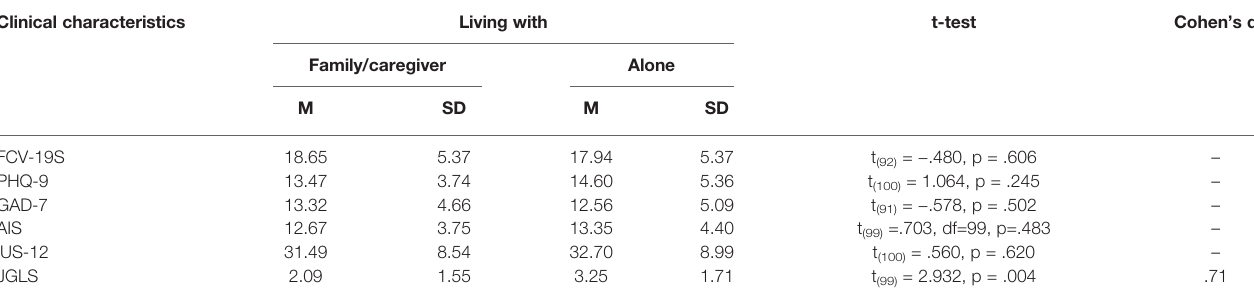
TABLE 2 | Clinical characteristics in relation with living status. Clinical